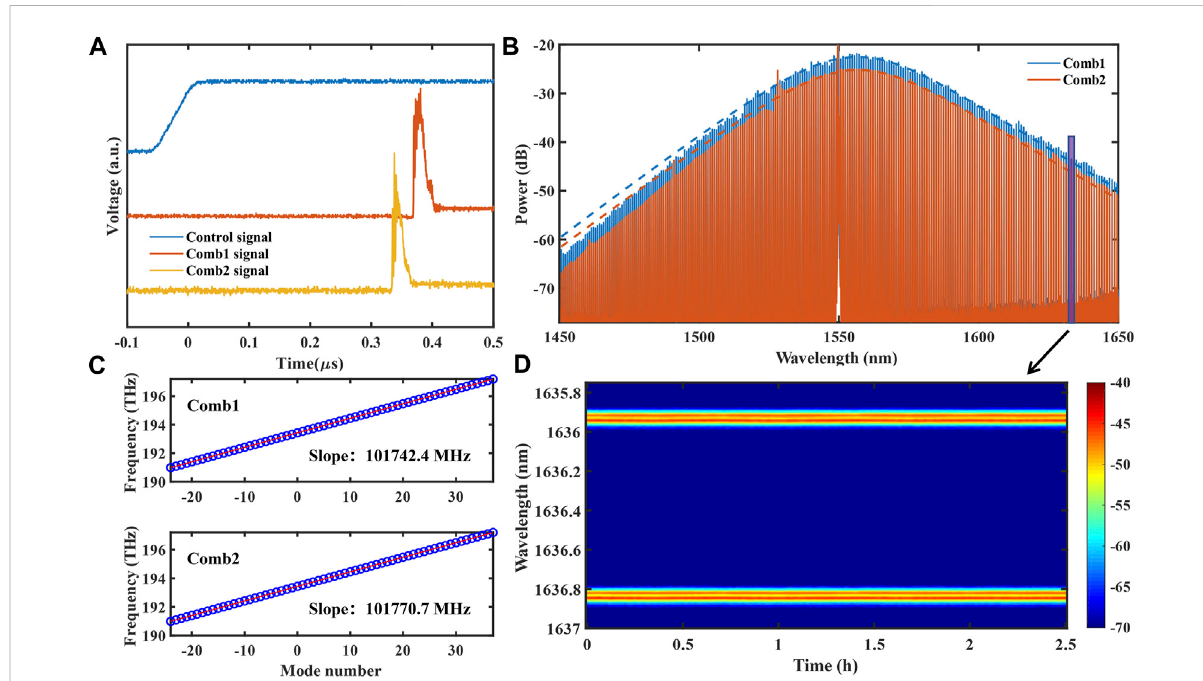
FIGURE 3 Soliton dual-microcomb generation and characterization. (A) Observed soliton steps versus scan time in the OSC. The blue curve represents the control signal of AWG to drive the VCO. The red and yellow curves show the power traces of the two soliton microcombs excluding the pump power. (B) Generatedtwosingle-solitonmode-lockedmicrocombopticalspectra.Two fi ttedsech 2 envelopesarealsoindicatedbytheblueandred dotted lines. (C) Characterization of two comb spacings over 60 comb lines and two linear fi ts. (D) Optical spectrum evolution color map beyond 2.5 h between 1635.8 nm and 1637 nm. The color bar re fl ects the power amplitude in the unit of decibel-milliwatts